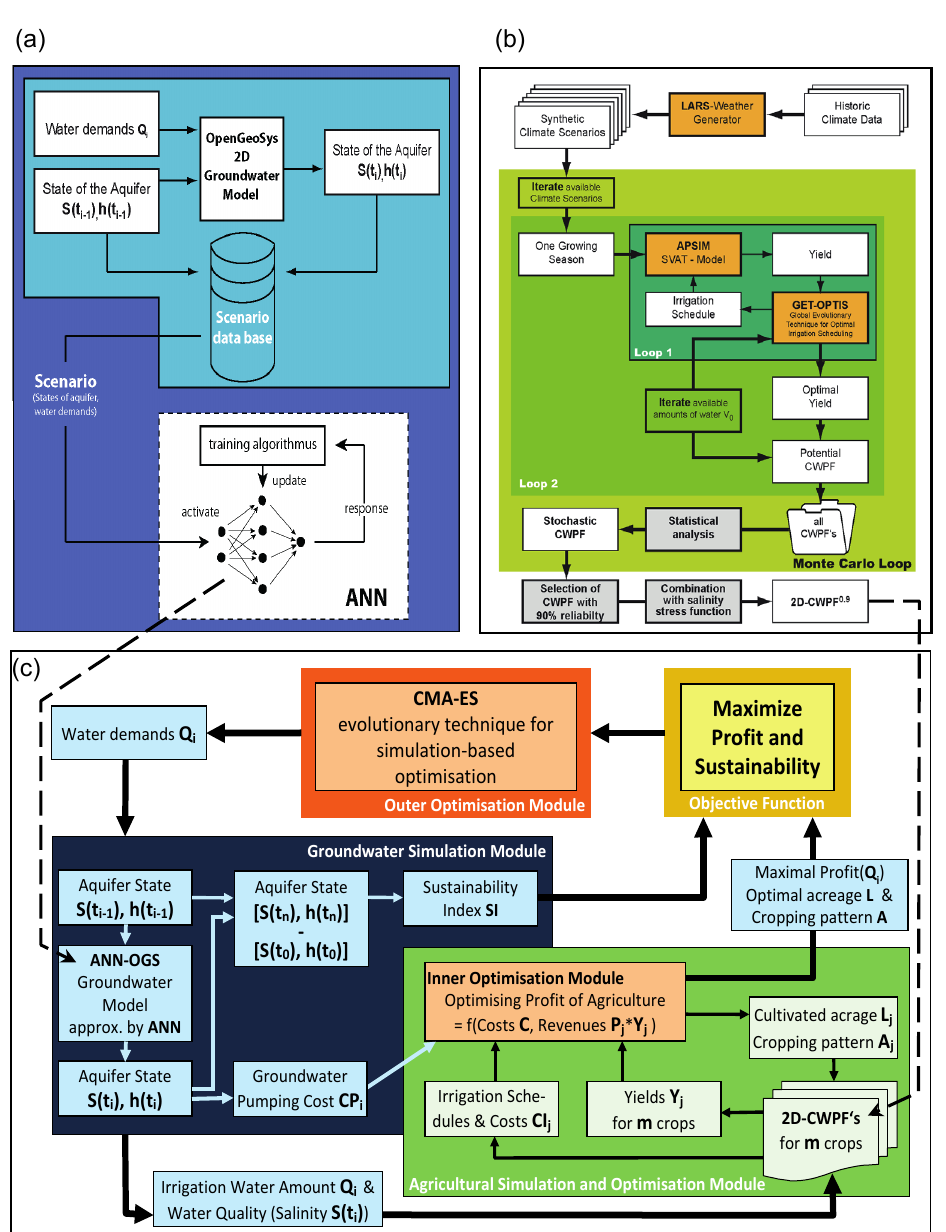
Fig. 1 Simulation-based integrated water management system consisting of: (a) the procedure of the set up of the surrogate model for describing the aquifer behaviour (ANN-OGS) (b) the estimation procedure for the 2D-crop-water-production function (2D-CWPF), and (c) the optimisation framework, which links the derived surrogate